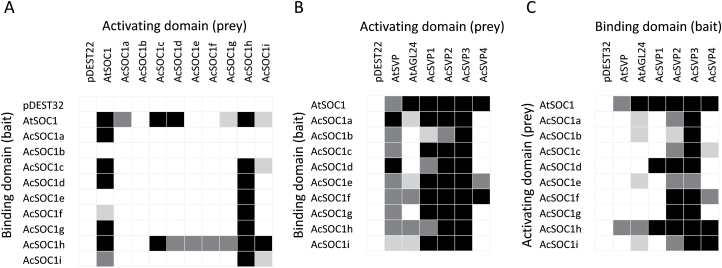
Summary of kiwifruit SOC1-like protein interactions detected by yeast two-hybrid analysis. (A) Homo- and heterodimerization of kiwifruit SOC1-like and Arabidopsis SOC1 proteins. (B, C) Heterodimerization of kiwifruit SOC1-like, SVP-like, and Arabidopsis SOC1, SVP, and AGL24. Black, very strong interaction; dark grey, strong interaction; light grey, weak interaction; white, no interaction. The summary is based on results presented in Supplementary Fig. S3 at JXB online.